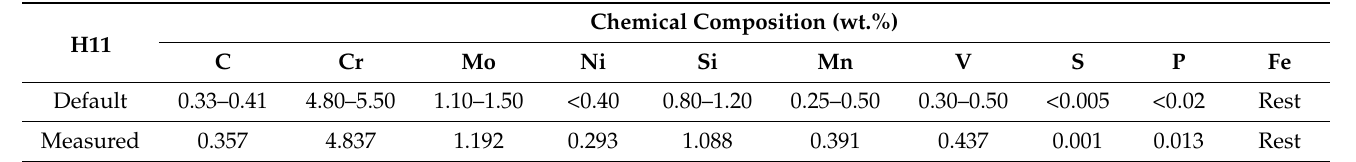
Table 1. Default and measured chemical composition of the H11 test material, measured with the optical emission spectroscopy device SPECTROLAB by the SPECTRO Analytical Instruments GmbH. Chemical Composition H11